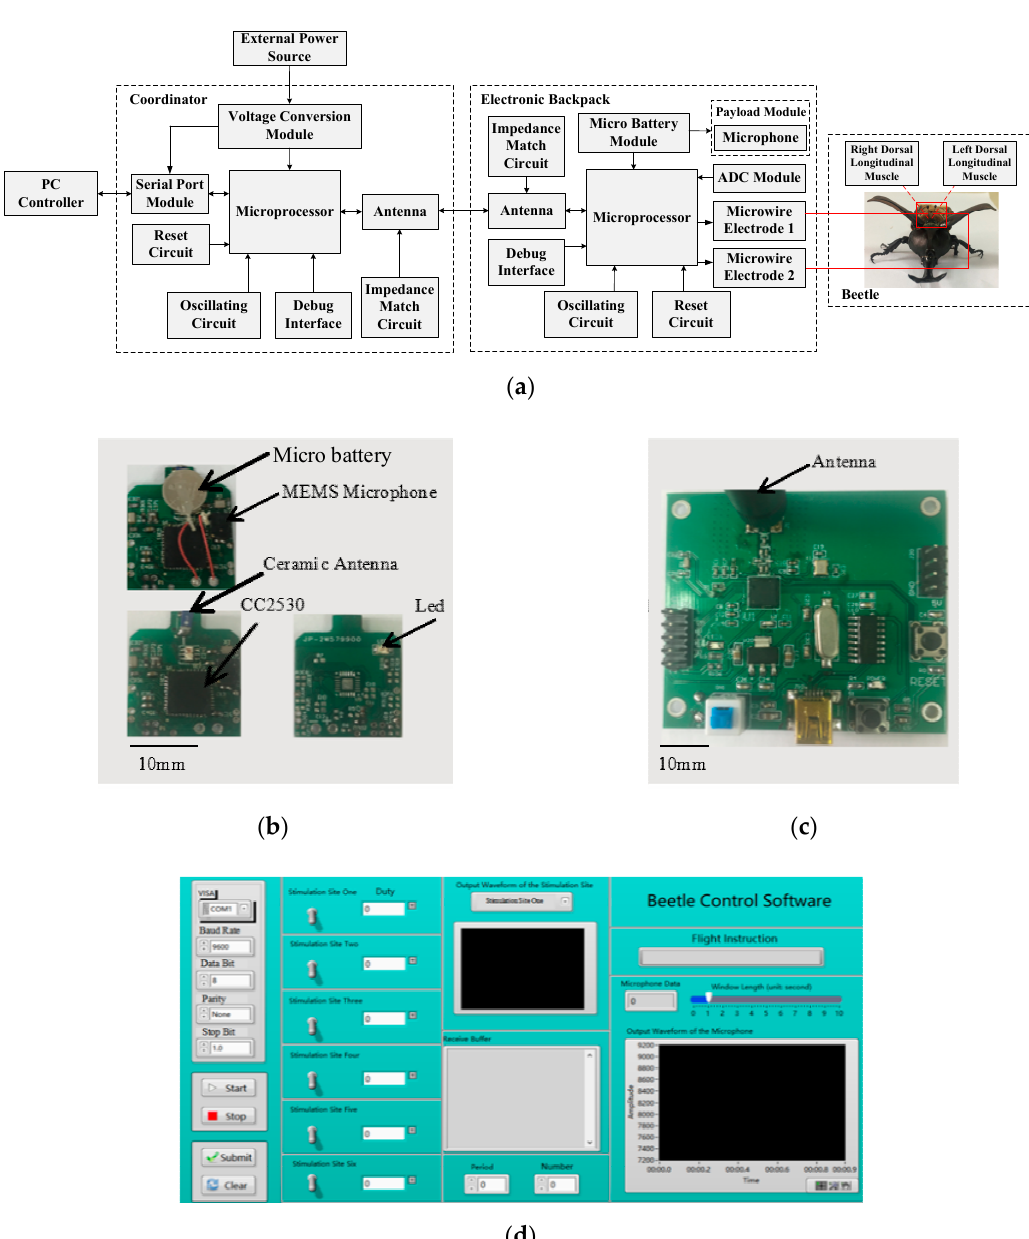
Figure 3. Micro-control system. ( a ) Schematic of the hardware design of micro-control system; ( b ) physical map of electronic backpack (16 mm × 16 mm); ( c ) physical map of coordinator; ( d ) PC controller interface.